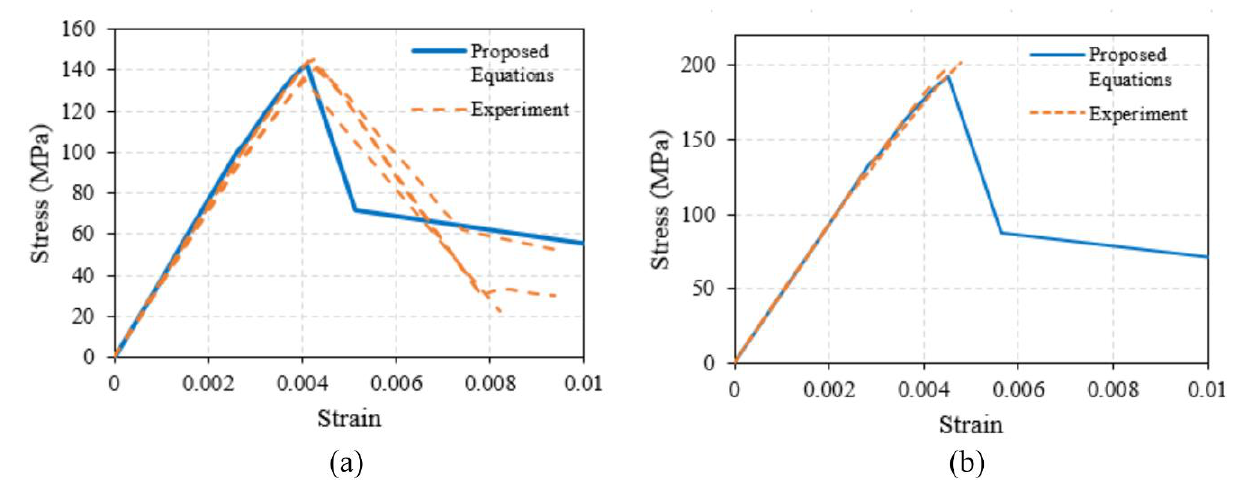
Figure 3. Comparison of the proposed compressive stress – strain approximation with test results. ( a ) Singh et al. experiments [34] , ( b ) this study.